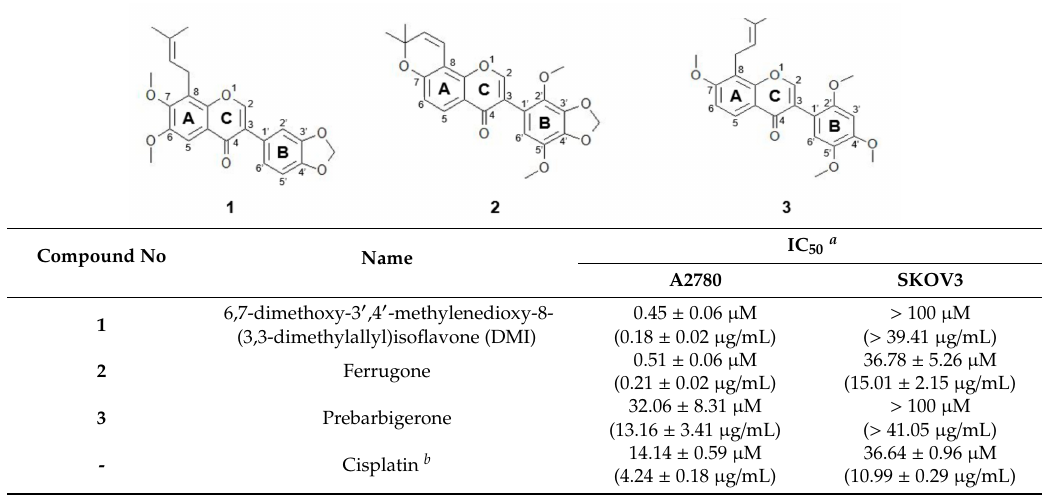
Table 1. Cytotoxic activity of isoflavones isolated from Millettia ferruginea spp. ferruginea in human ovarian cancer